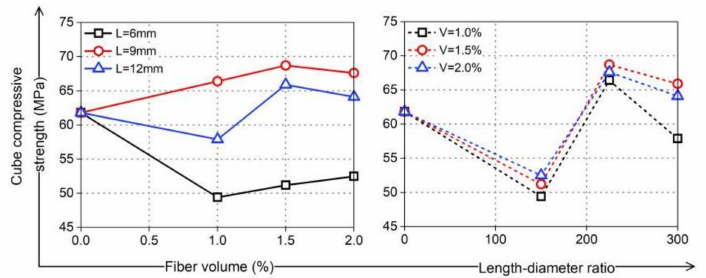
Figure 9. Cubic compressive strength of PVA-reinforced coral cement-based